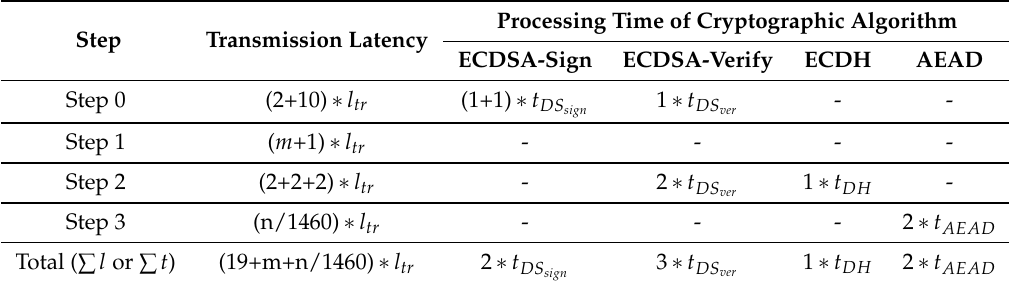
Table 3. The summary of processing time of proposed D2D